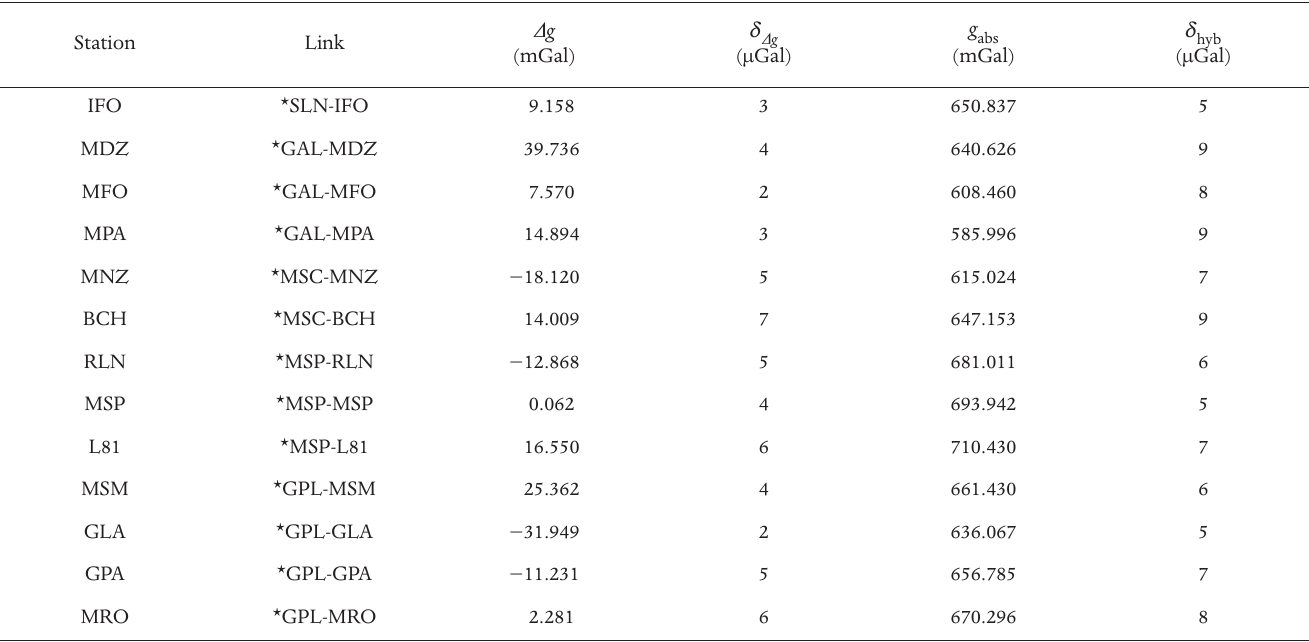
Table 3. Results of the hybrid gravity measurements acquired in 2010 for the 13 selected relative gravity stations and the five absolute gravity reference points of the Mt. Etna gravity network. The columns indicate, respectively, the relative stations acronym, the links between the relative stations and an ), the absolute gravity values acquired at the absolute reference point, the gravity differences ( D g ) between them and their associated uncertainty ( d D g ), and the associated uncertainties ( d ). Each relative station was linked with the closest absolute reference point by the FG5#238 absolute gravimeter ( g abs hyb reference point, as indicated with the symbol